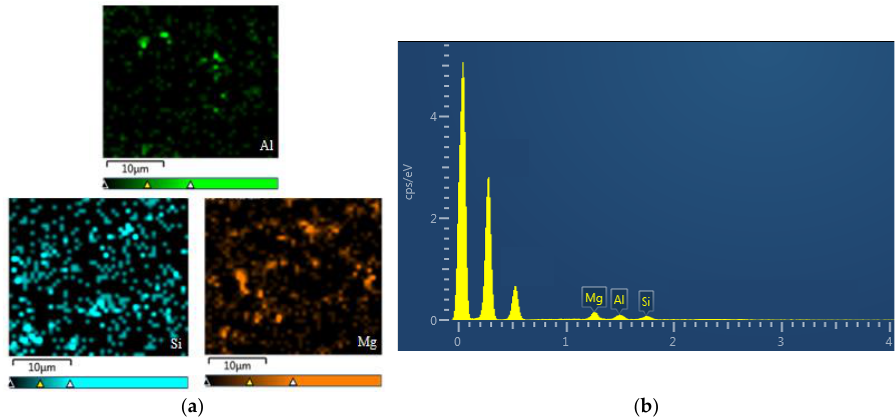
Figure 6. Tensile cross-sectional EDS diagram after doping with filler: ( a ) Distribution diagram of different elements; ( b ) EDS spectra.